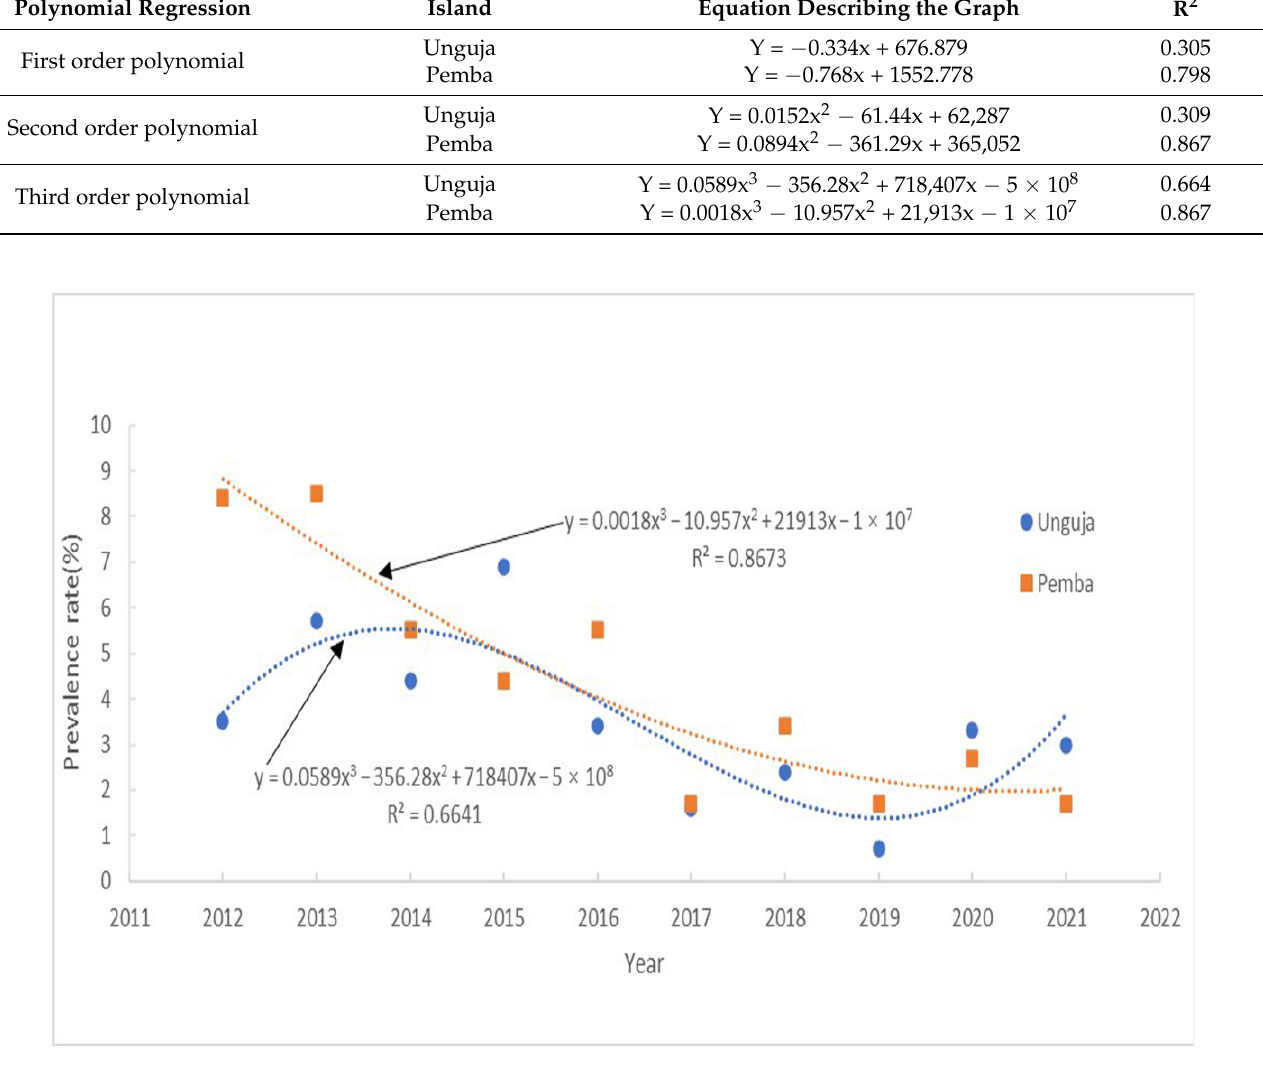
Figure 2. Testing curves showing schistosomiasis prevalence in Unguja and Pemba according to